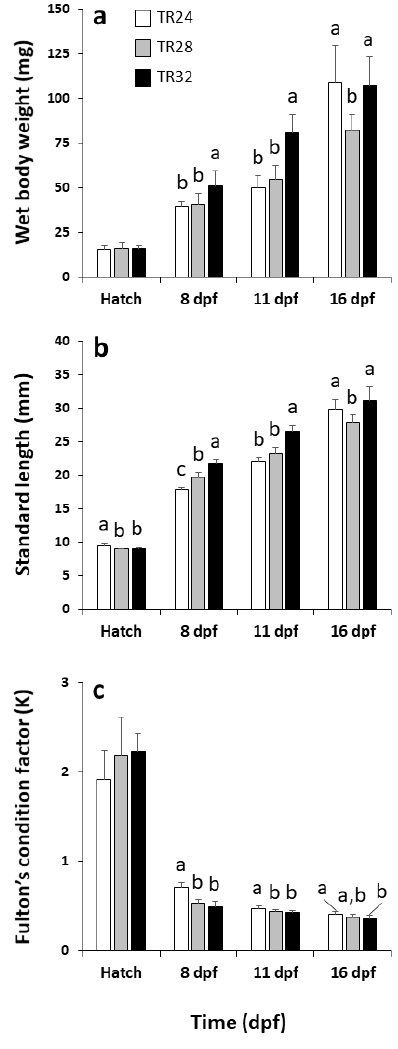
Figure 4. Growth performance (mean ± standard deviation) of Atractosteus tropicus larvae when embryos were incubated at different thermal regimens. Wet body weight ( a ), Standard length ( b ), and Fulton’s condition factor ( c ). Lowercase letters at the top of each bar indicate statistical differences among experimental groups at the specific developmental sampling time (ANOVA, p < 0.05; N = 10). White bars, TR24; grey bars, TR28; and black bars, TR32.